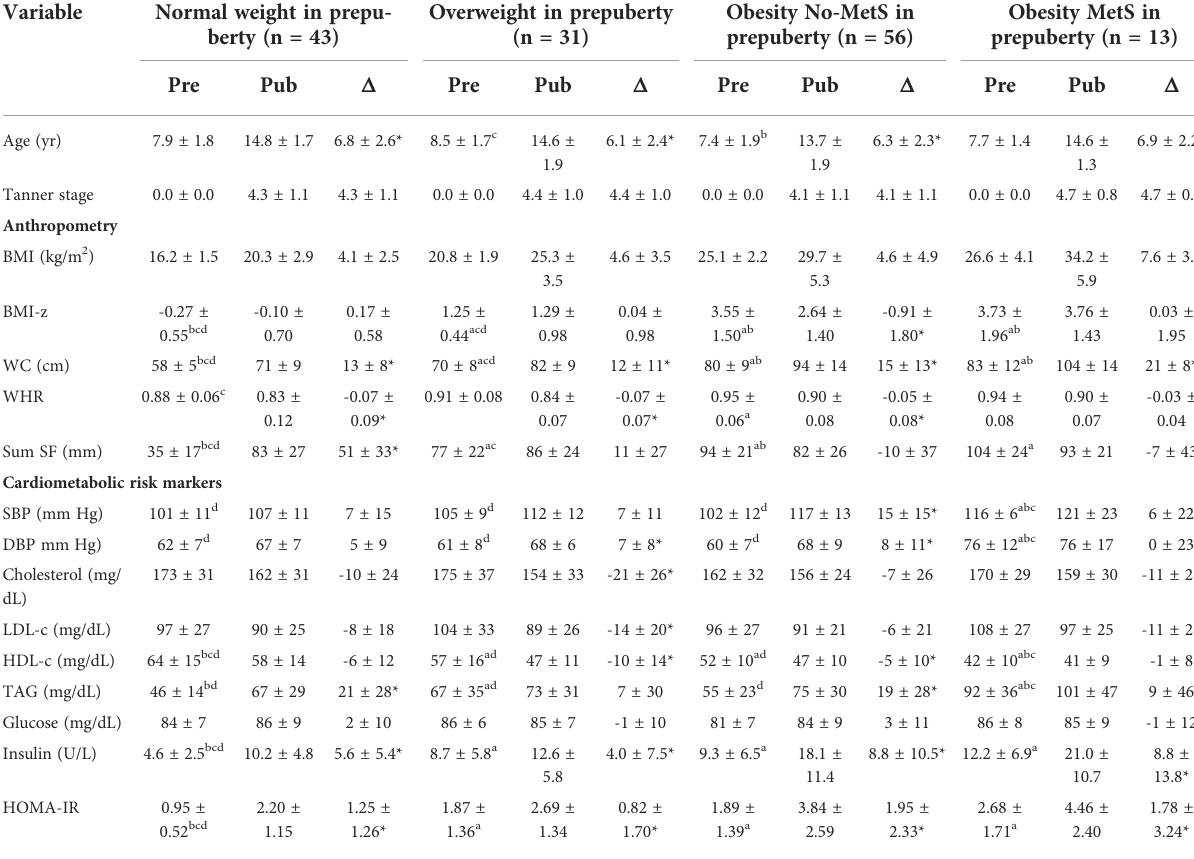
TABLE 2 Pre and pubertal levels and change of anthropometry and cardiometabolic risk markers, grouped by BMI status in prepuberty.